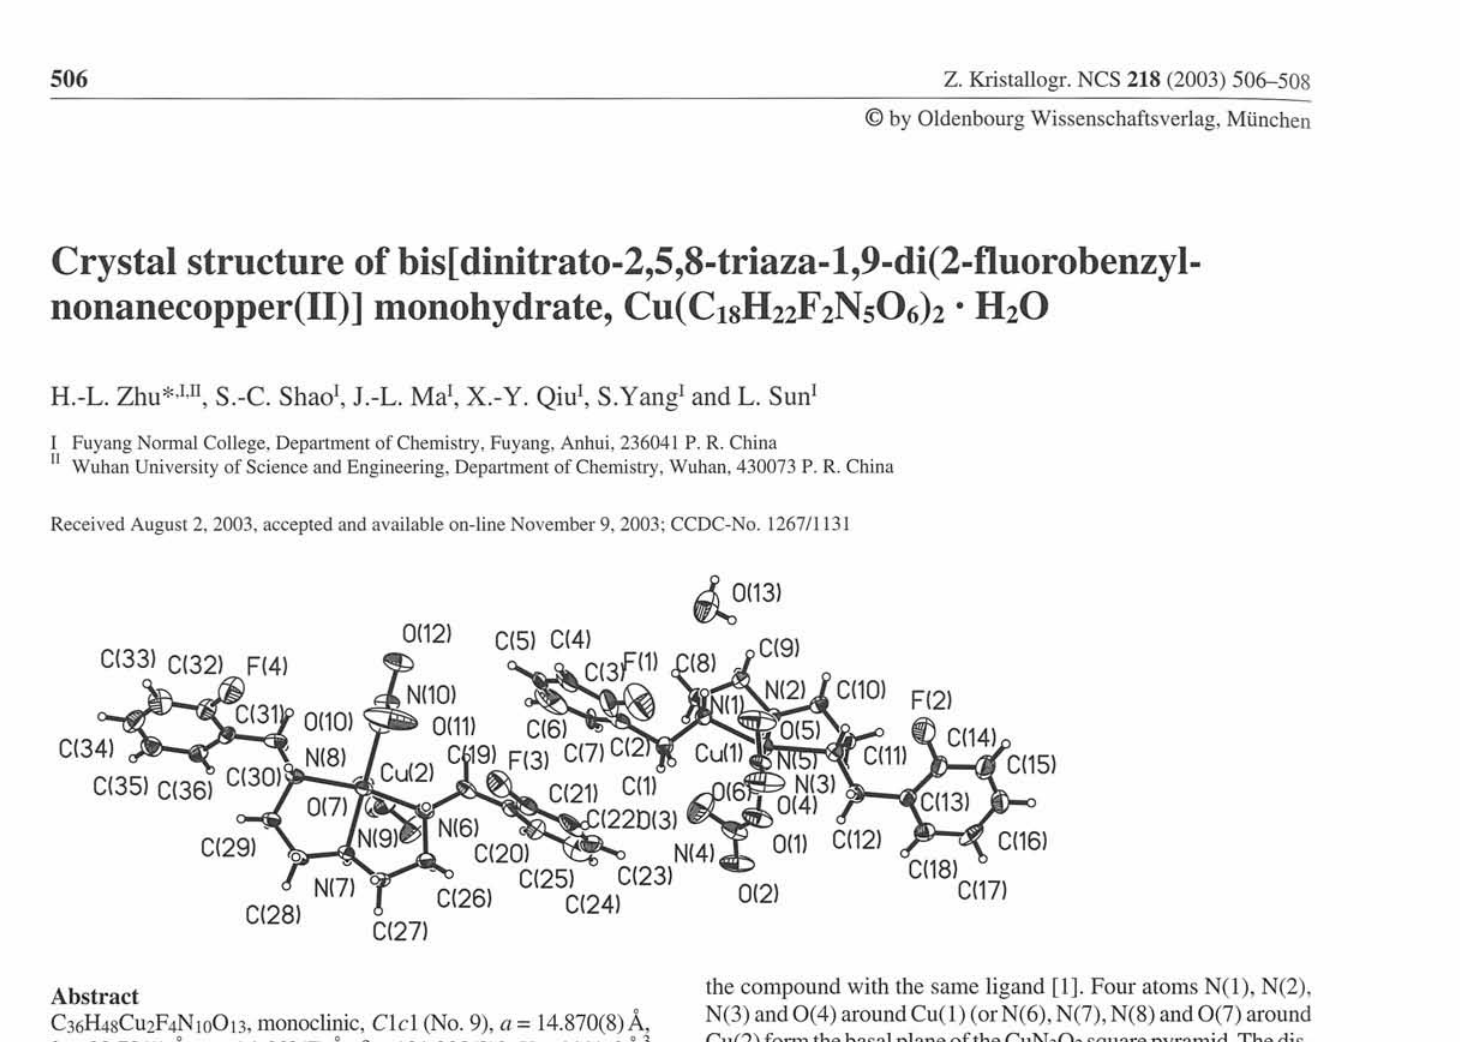
Table 1. Data collection and